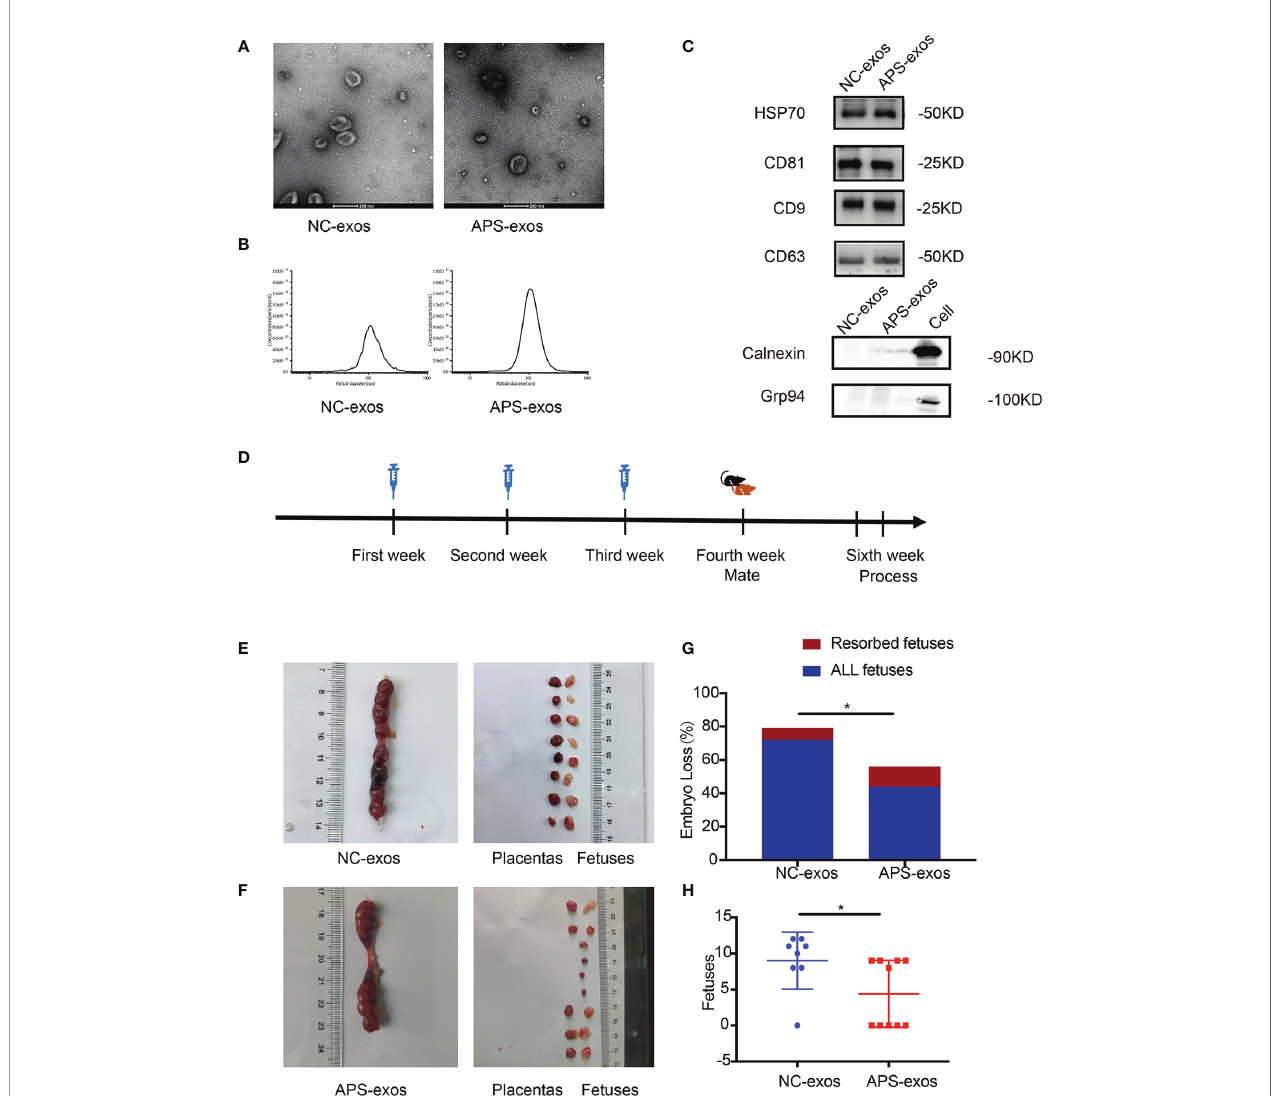
FIGURE 1 | (A) Transmission electron microscopy (TEM) images of collected exosomes. Scale bars in the images represent 200 nm. (B) Diagram of the particle size distribution obtained by nanoparticle tracking analysis. (C) Con fi rmation of marker proteins in the exosome (exos) preparations. Western blotting of samples for HSP70, CD81, CD9, CD63, Calnexin and Grp94. (D) The mice were injected with antiphospholipid syndrome (APS)-exos (100 m g/ml/each) or normal control (NC)- exos (100 m g/ml/each) via the caudal vein once a week for 3 continuous weeks. Seven days after the fi nal immunization, the treated female BALB/c mice were mated overnight with male mice. Mating was detected by the appearance of a vaginal plug the following morning. On days 12 – 14 after mating, all female mice were sacri fi ced. (E, F) Establishment of the abortion model. Typical uterus and embryos from a mouse treated with APS-exos. (G) The bar shows the percentage of embryo-fetal loss in the different groups. APS-exos increased the abortion rate of mice (NC-exos, n = 7 and APS-exos, n = 5, *P = 0.038 by chi-square test). (H) The scatter plot shows the pregnancy rates in different groups. APS-exos reduced the pregnancy rate. (NC-exos, n=8 and APS-exos, n =10, *P = 0.029 by Mann – Whitney test).